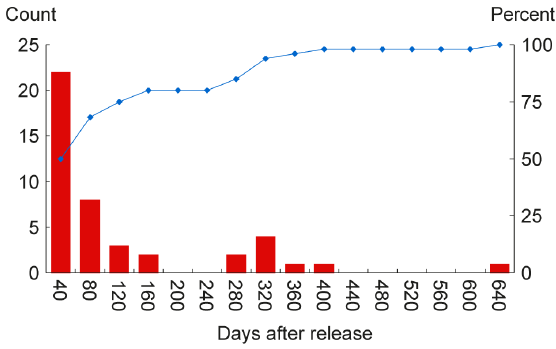
Figure 2. Return rates of tagged crabs. Return rate of edible crabs tagged with electronic data storage tags recaptured per 40 day time interval following release (histogram), and cumulative percentage recapture by time